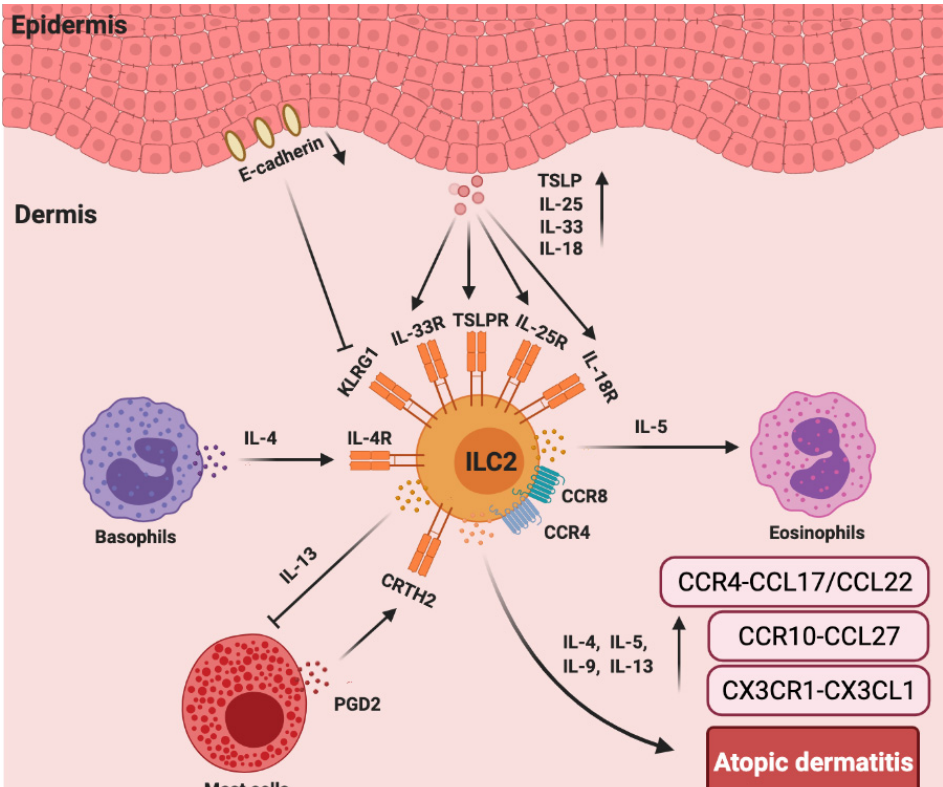
Figure 3. The roles chemokines and group 2 ILCs in the pathogenesis of atopic dermatitis (AD). In AD skin, there are more ILC2s and increased TSLP, IL-25R, IL-33R, IL-18R, and CRTH2 expression in lesioned skin from AD patients compared to that of healthy controls. ILC2s, basophils, and eosinophils colocalize in AD skin lesions. Basophils-secreted IL-4 induces ILC2s accumulation, and ILC2s-secreted IL-5 recruits eosinophils that accelerate AD inflammation. CCR4 and CCR8 are also important for the recruitment of ILC2s to the lesioned skin site. PGD2, which is produced by mast cells, binds to CRTH2 to induce migration and type 2 cytokine (IL-4, IL-5, IL-9, and IL-13) production by ILC2s. ILC2-expressed IL-13 can abolish IgE-dependent cytokine release by mast cells. Furthermore, E-cadherin production by keratinocytes is decreased in AD skin, which impairs the negative regulation of ILC2s via KLRG1. The levels of CX3CR1–CX3CL1, CCR10–CCL27, and CCR4–CCL17/CCL22 are significantly increased in the AD skin.